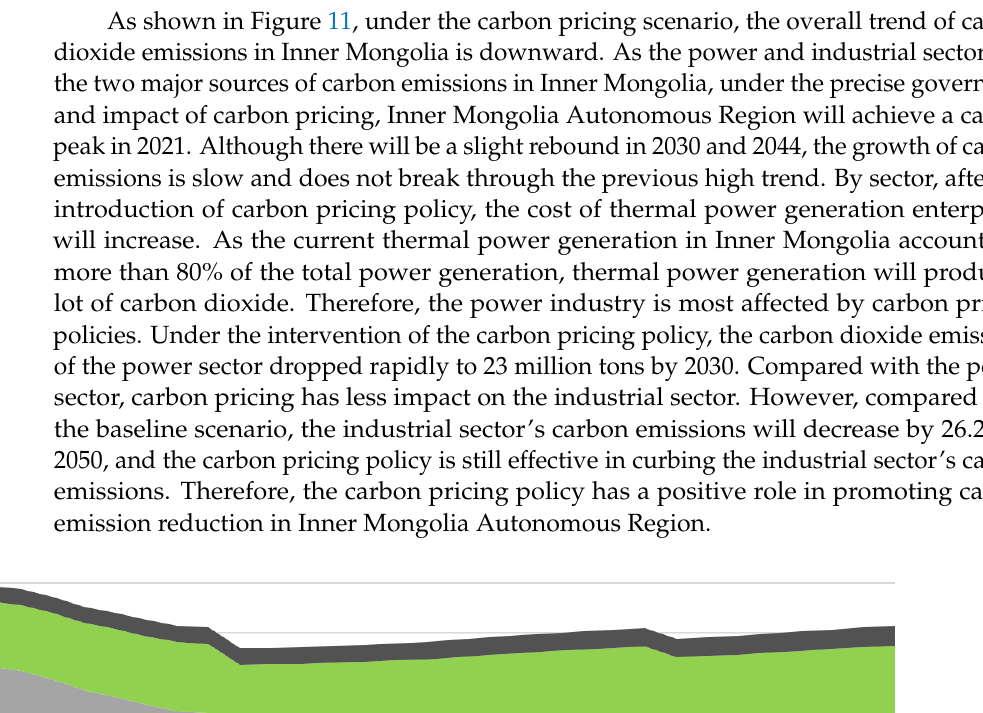
Figure 10. Power generation change in Zhejiang Province under carbon pricing scenario.